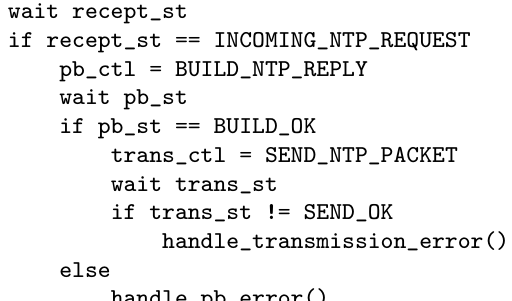
Figure 15. Time server service control algorithm. Error handling intentionally omitted for simplicity.